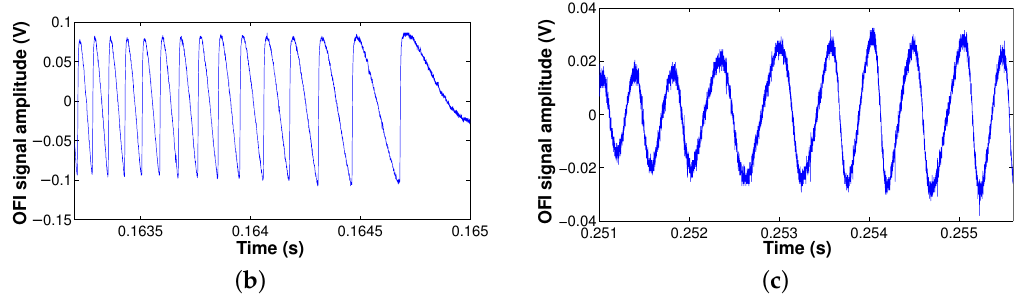
Figure 7. Measured OFI signal obtained using the experimental setup described in Figure 6 exhibiting strong variations in both amplitude an optical coupling factor C . ( a ) Full acquisition that highlights the strong amplitude modulation induced by the speckle phenomenon; ( b ) truncation of the time-domain signal showing a high C value; ( c ) truncation of the time-domain signal showing a lower value for the optical coupling factor C .